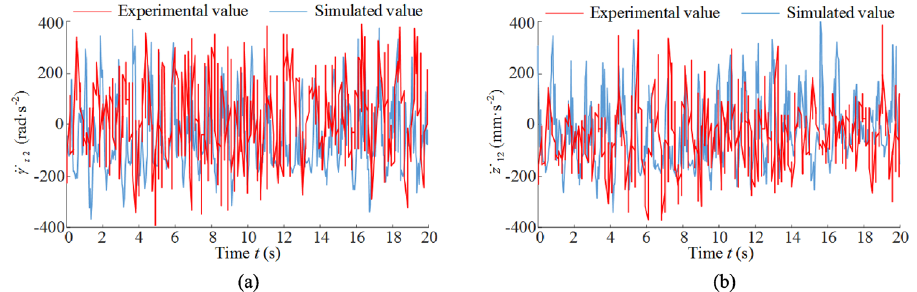
Figure 14. Vibration acceleration: ( a ) ranging arm, ( b ) walking unit.